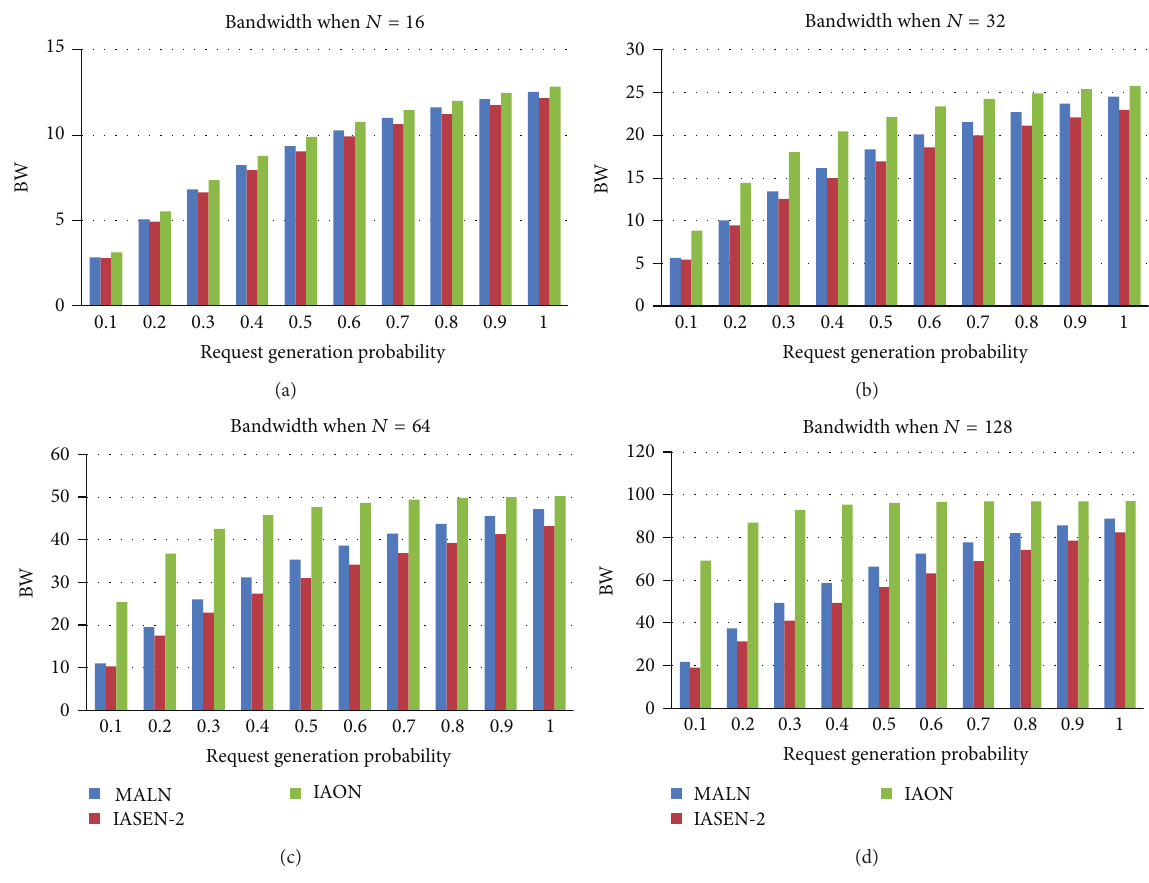
Figure 8: The bandwidth of MALN, IASEN-2, and IAON when network sizes are 16, 32, 64, and 128 separately.